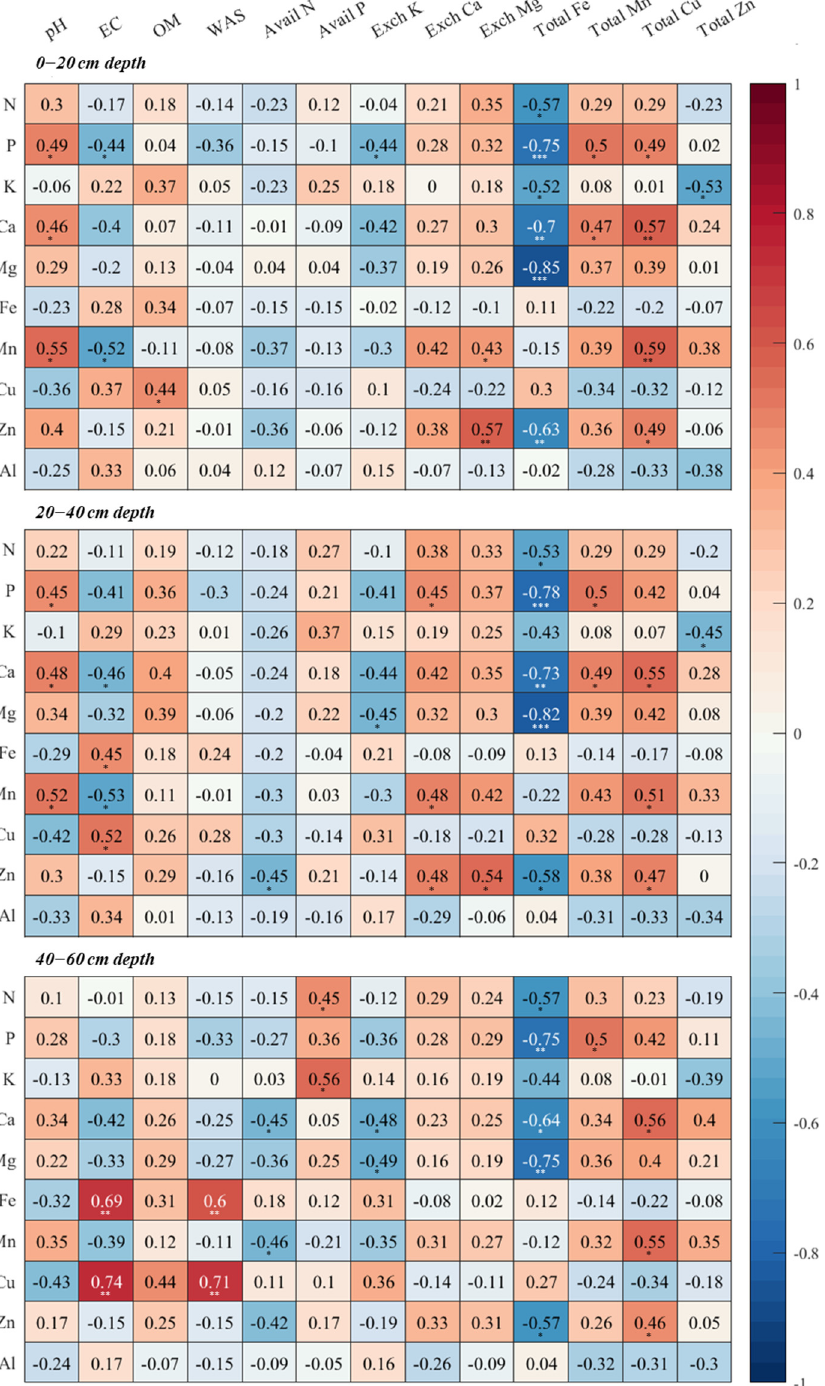
Figure 3. Heatmap of the correlation coefficient between different soil depth properties and elements in Sijichun leaves. The soil properties are depicted on the horizontal axis while the elements are depicted on the vertical axis. *: p < 0.05; **: p < 0.01; ***: p < 0.0001. Abbreviations: EC, electrical conductivity; OM, organic matter; WAS, wet aggregate stability; Avail., Available; Exch.,